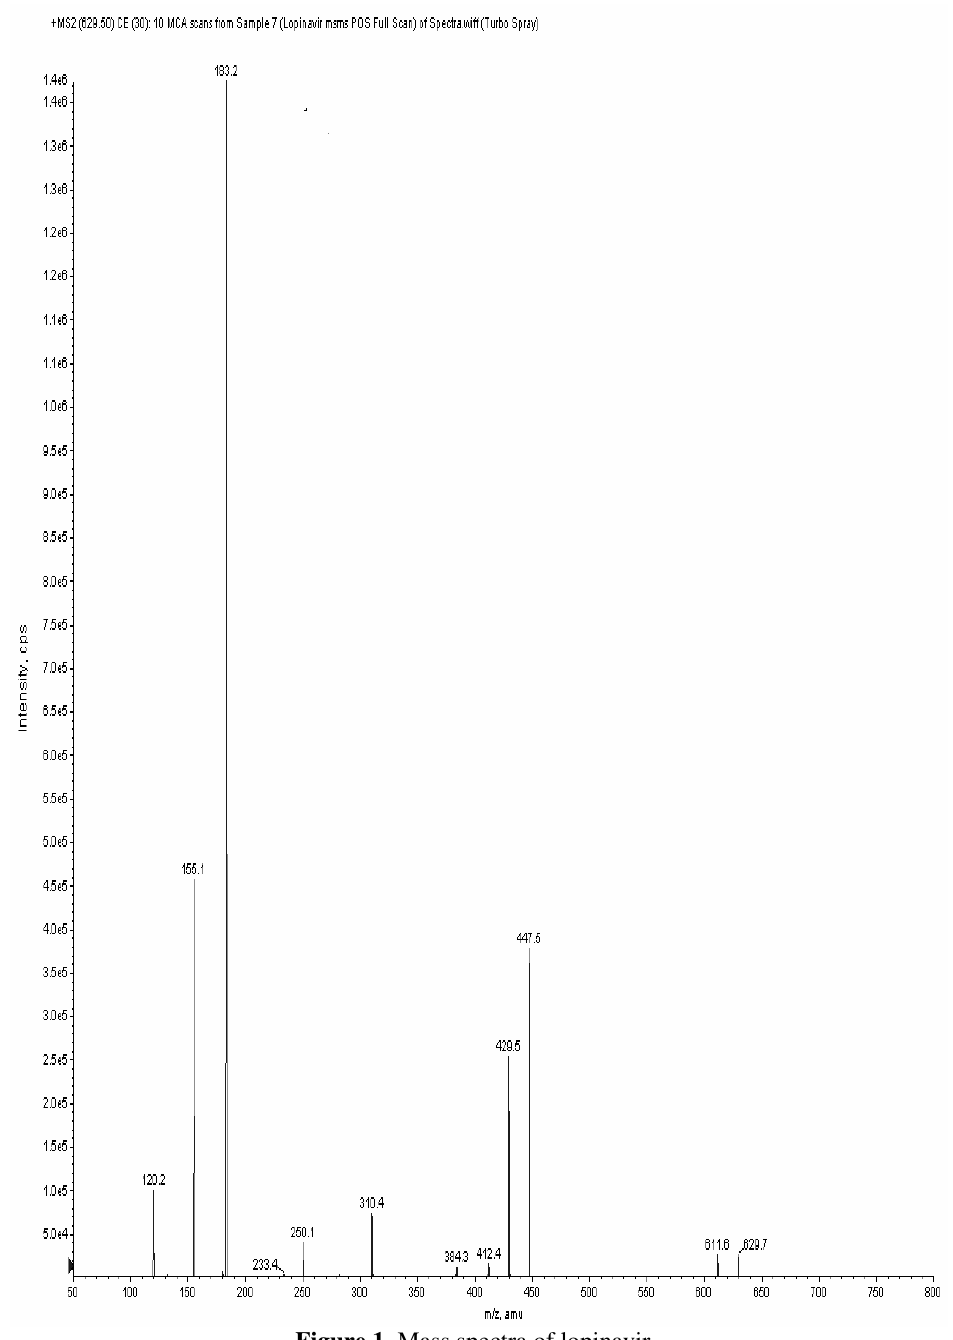
Figure 1. Mass spectra of